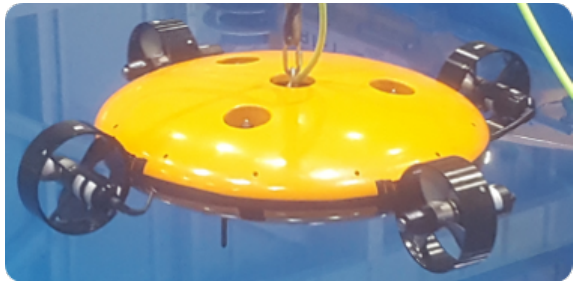
Figure 1. Developed unmanned underwater vehicle (UUV) platform with the flattened ellipsoidal